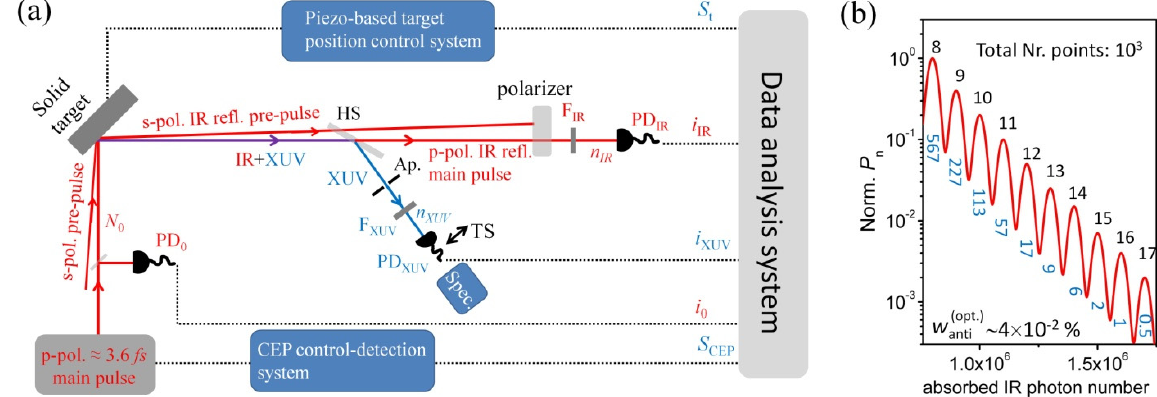
Figure 4. ( a ) A drawing of the proposed experimental set-up based on the operation principle of the QS described in Section 2, and the RHH beam line. A p-polarized ≈ 3.6 fs CEP stable IR pulse of N 0 ∼ 10 16 photons per pulse is focused onto rotating disc shape solid target. The plasma expansion is initiated by an s-polarized pre-pulse arriving on the target few-ps before the main pulse and at slightly different angle of incidence. The symbols of HS, F XUV , F IR , PD 0 , PD IR , PD XUV , i IR , i XUV , i 0 , n IR and n XUV , are the same as those used in Figure 1. The PD XUV is placed on a translation stage (TS) in order to be able to move it out of the XUV beam path and record the XUV spectrum by a conventional XUV spectrometer (Spec.). Ap.: An aperture serving as spatial filter in order to optimize the transmission/detection of the RHH. The polarizer after the HS plate is used in order to block the IR photons of the reflected by the solid s-pol. pre-pulse. In this arrangement together with i IR , i XUV and i 0 photocurrents, the variations of the CEP ( S CEP ) and target position ( S t ) are recorded for each laser shot. ( b ) A simplified calculation (performed for visualization reasons) of the multi-peak structure of P n which corresponds to the number of IR photon absorbed towards RHHG. The distribution has been calculated by considering a sum of Gaussian peaks, using as relative amplitudes and widths, the amplitudes and the widths of the harmonics shown in Figure 3b. Also we have considered that, N 0 ∼ 10 16 , η XUV ∼ 10 − 3 –10 − 2 , an IR attenuation factor of 10 8 , a negligible contribution of the IR uncorrelated points, and that the total number of points along the anticorrelation diagonal is 10 3 . The numbers in blue show the numbers of points contributing in each peak of the P n . The peak corresponding to the 17th and 16th harmonics (and maybe 15th), practically cannot be resolved because they contain 1 and 0.5 points, respectively.